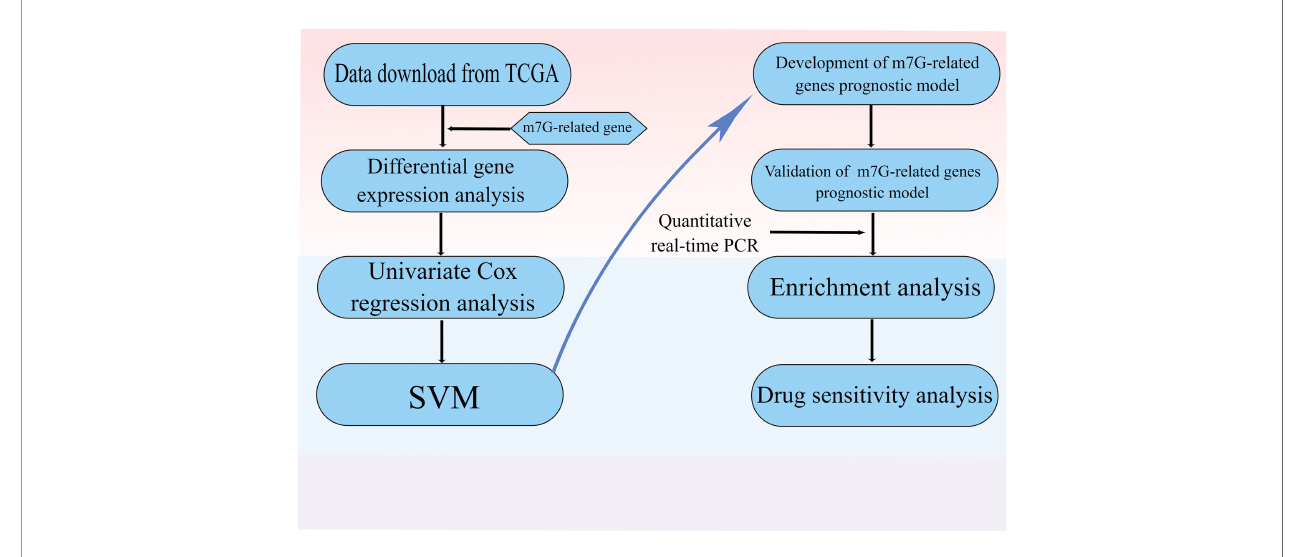
FIGURE 1 | Flow diagram.